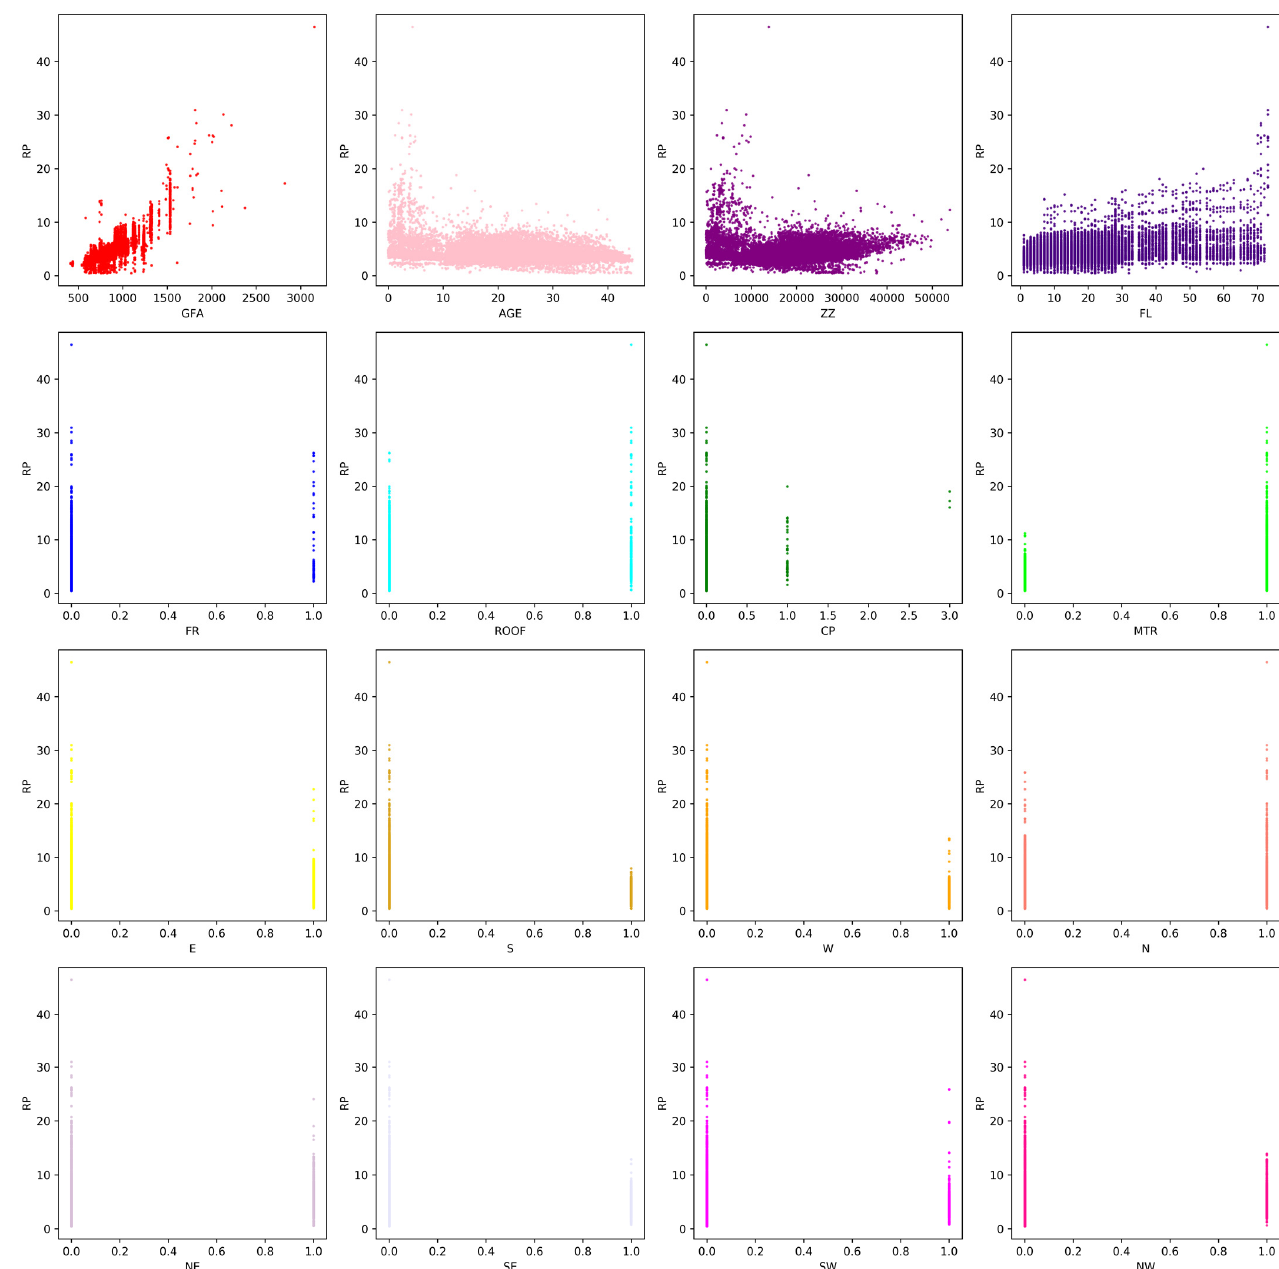
Figure 3. Data visualization. Figure 3. Data Table 2. Descriptive Statistics.